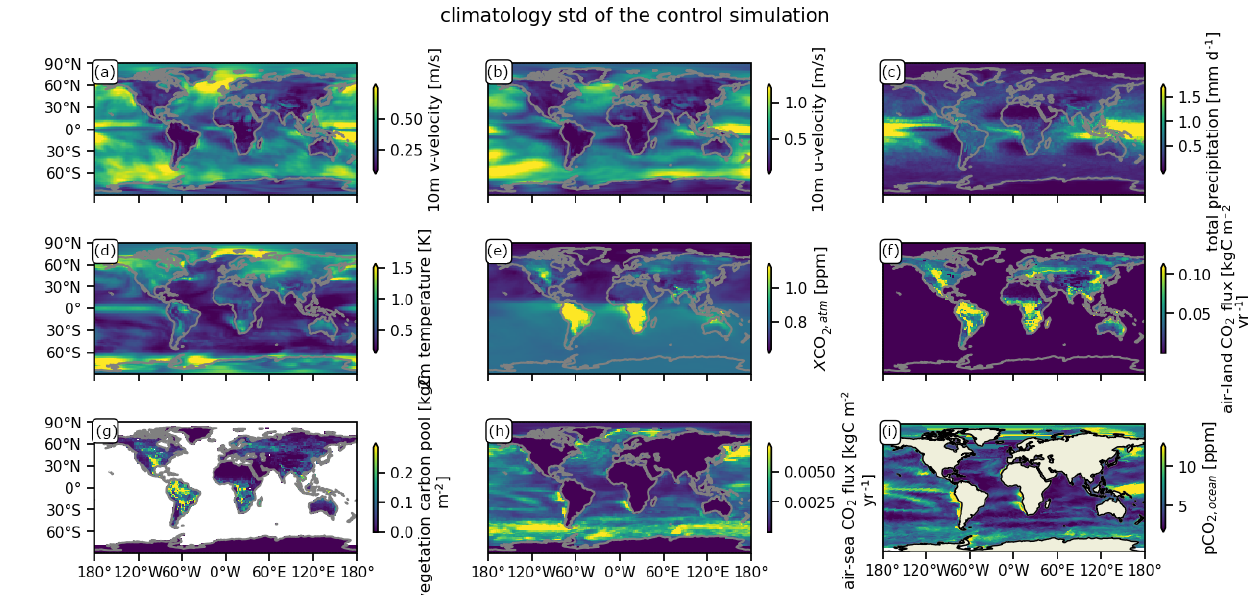
Figure G2. Temporal internal variability expressed as temporal standard deviation from the control simulations for all variables.